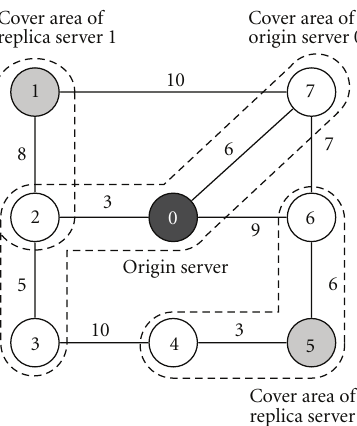
Figure 2: The optimal solution, where the distance constraint q ( u ) = 8. The number of replica servers is 2. number of links connected to a neighbor node. Greedy algo-